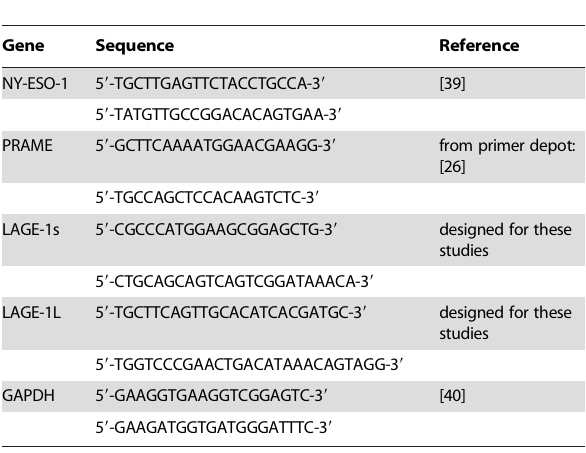
Table 1. qRT-PCR primers used for these experiments.